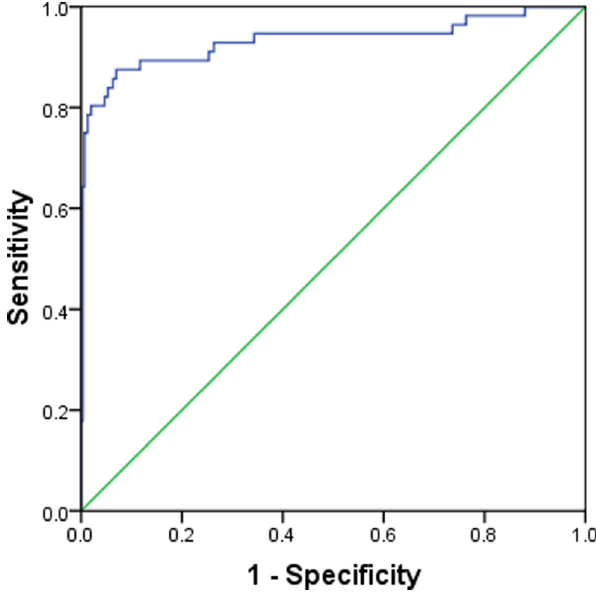
Figure 1. ROC plot of PSSM-based SVM model. The ROC curve depicts relative trade-offs between true positive and false positives. The green line is the reference line while the blue curve represents the ROC curve for the PSSM-based SVM model with an Area Under Curve (AUC) of 0.933.